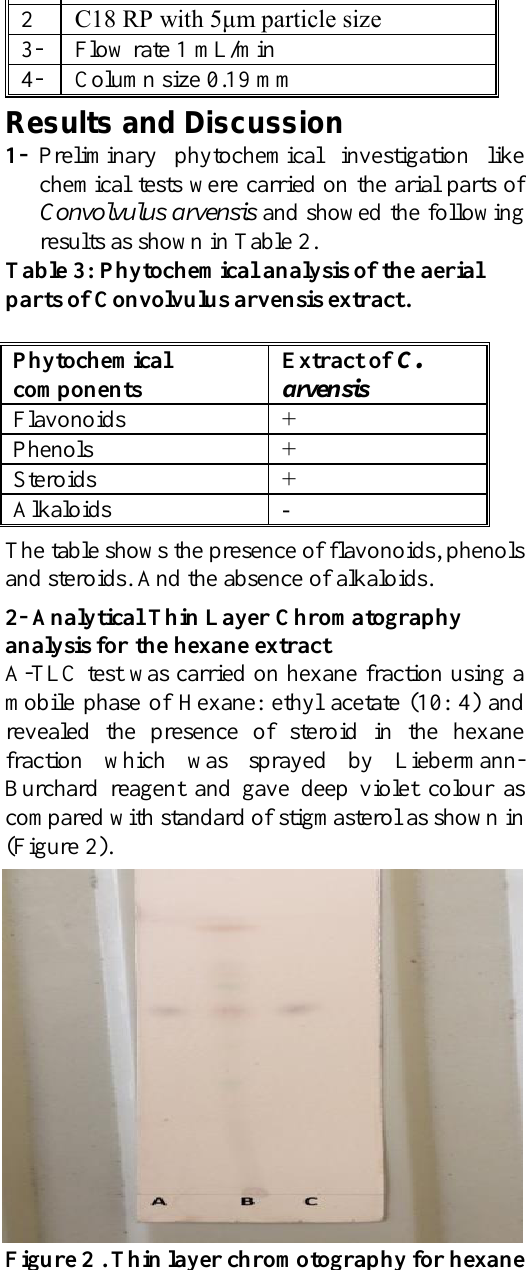
Table 2. LC mass condition for steroids 1- mobile phase, solvent A: 0.05% TFA in water, solvent B 0.05% TFA in methanol (pH 2.5).